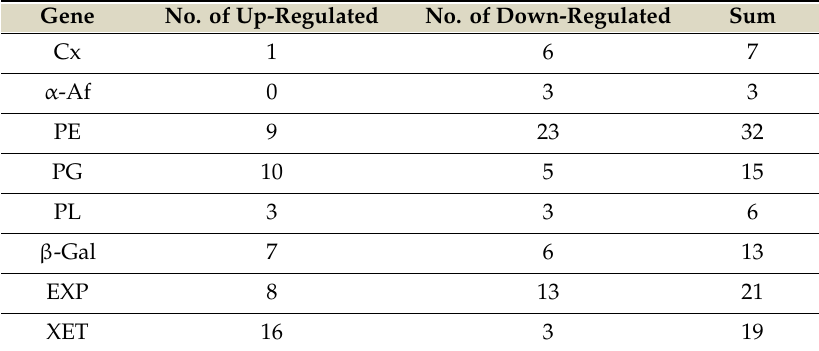
Table 2. Changes in cell wall softening-related enzyme genes under TA treatmen. Gene